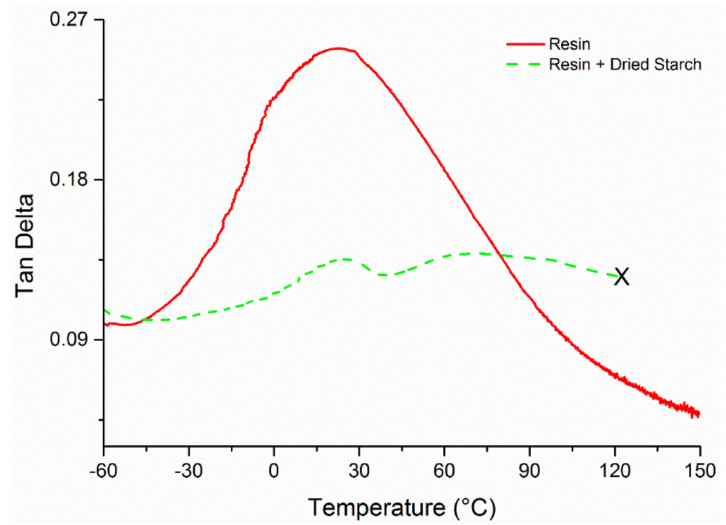
Figure 6. Tan delta vs. temperature curves of selected samples: unreinforced resin, and starch composite with composition 8. The resin contained 30 wt.% of BMA, 20 wt.% of DVB, 40 wt.% of tung oil, and 10 wt.% of asolectin, and was cured at 140 ◦ C for 3 h and 20 min. Premature yielding of the sample is indicated with the symbol “X”.